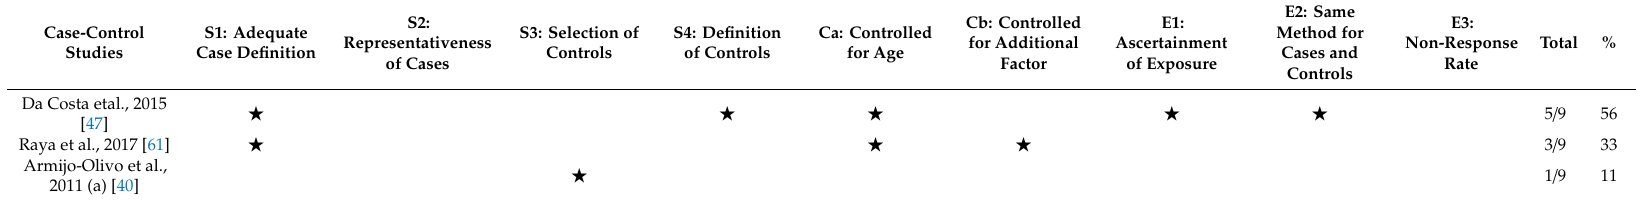
Table 2. Quality appraisal case-control studies.